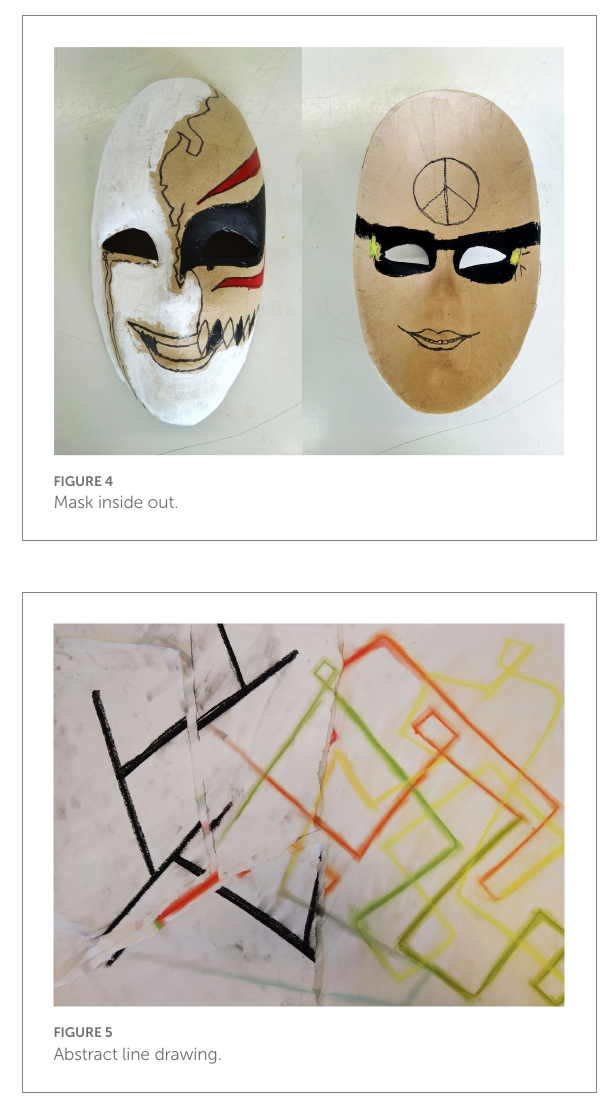
FIGURE 5 Abstract line